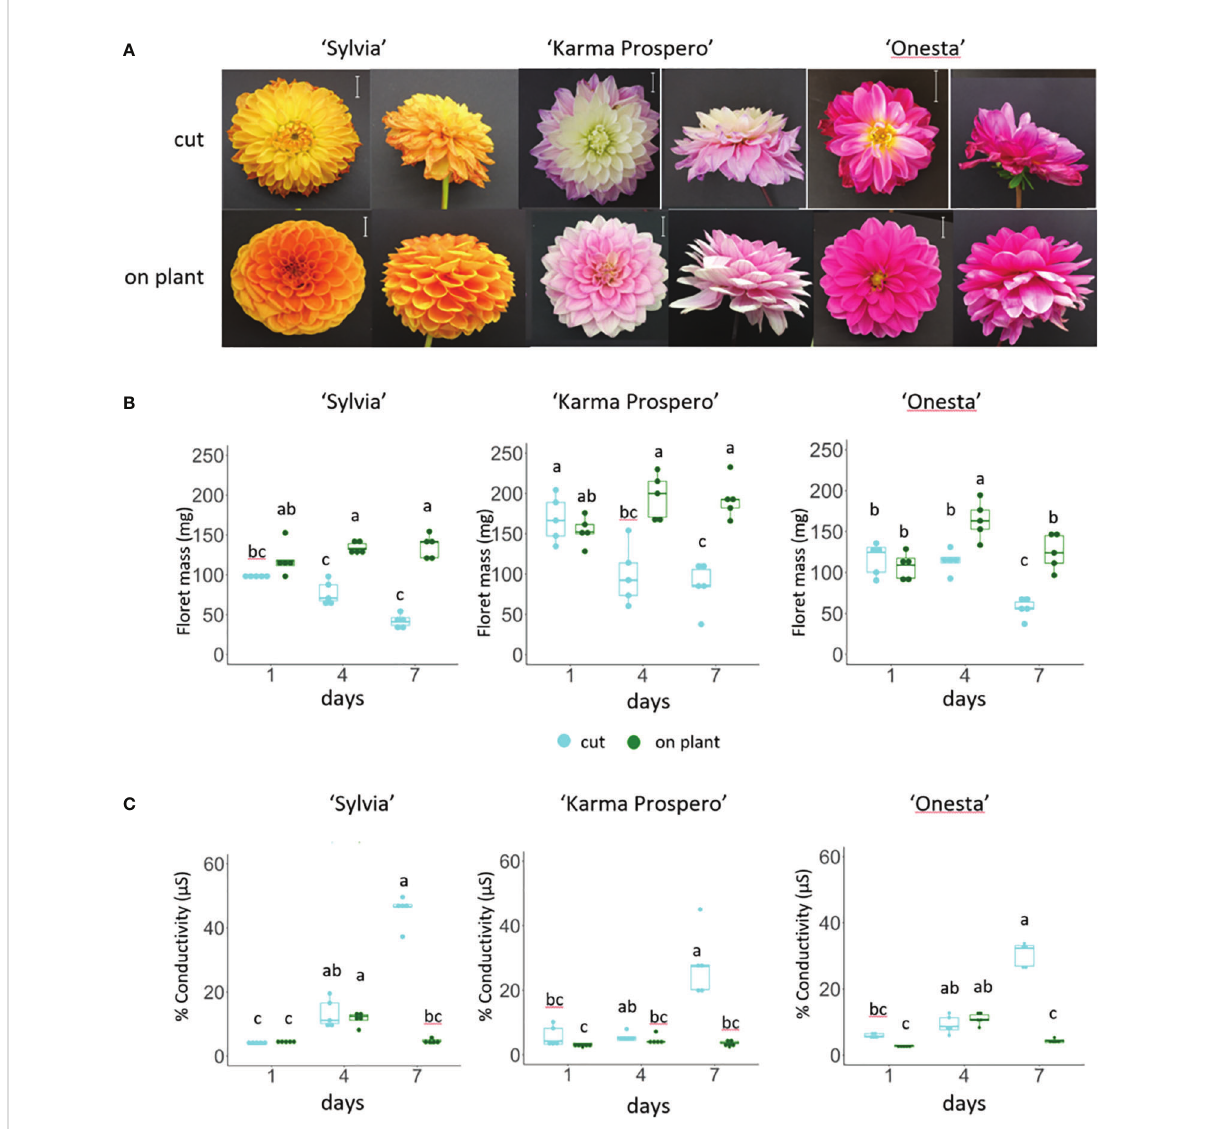
FIGURE 1 Floret senescence in dahlia cv.s Sylvia, Karma Prospero and Onesta in response to cutting from the plant (A) fl ower head appearance 7 days after harvesting at Stage III: cut fl ower stems were held in distilled water, compared to uncut fl owers left on the plant; (scale bars represent 20 mm); (B) fl oret mass (C) ion leakage, in mid-whorl fl orets 1, 4 and 7 days after cutting stage (n=5). Different letters indicate signi fi cant differences p < 0.05, based on a 2-way ANOVA followed by a Tukey ’ s test or a Kruskall Wallis test followed by a Dunn ’ s post hoc test if the data did not fi t the normality and equal variance criteria